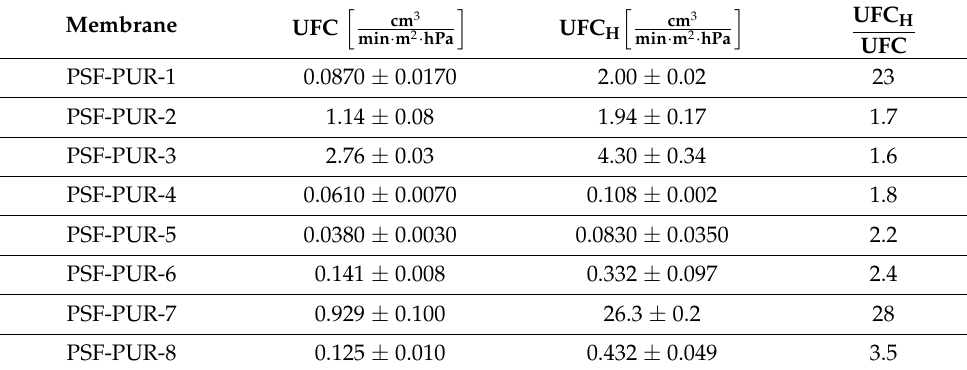
Table 3. Ultrafiltration coefficients before and after the hydrolysis process. Membrane UFC